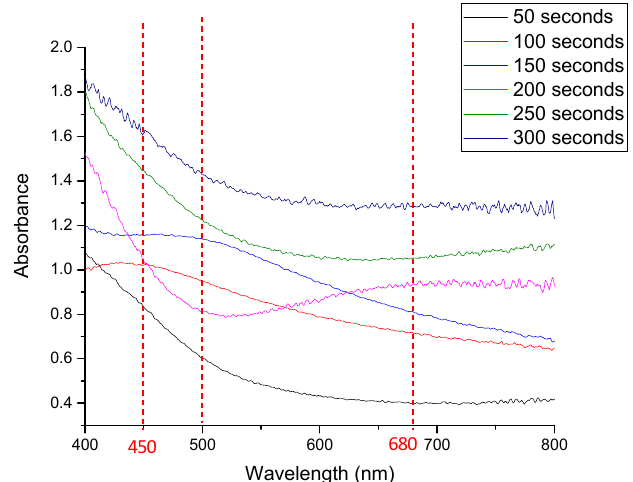
Figure 6. UV-vis absorption spectra of SERS active substrate with different sputtering durations of 50, 100, 150, 200, 250 and 300 s, respectively.